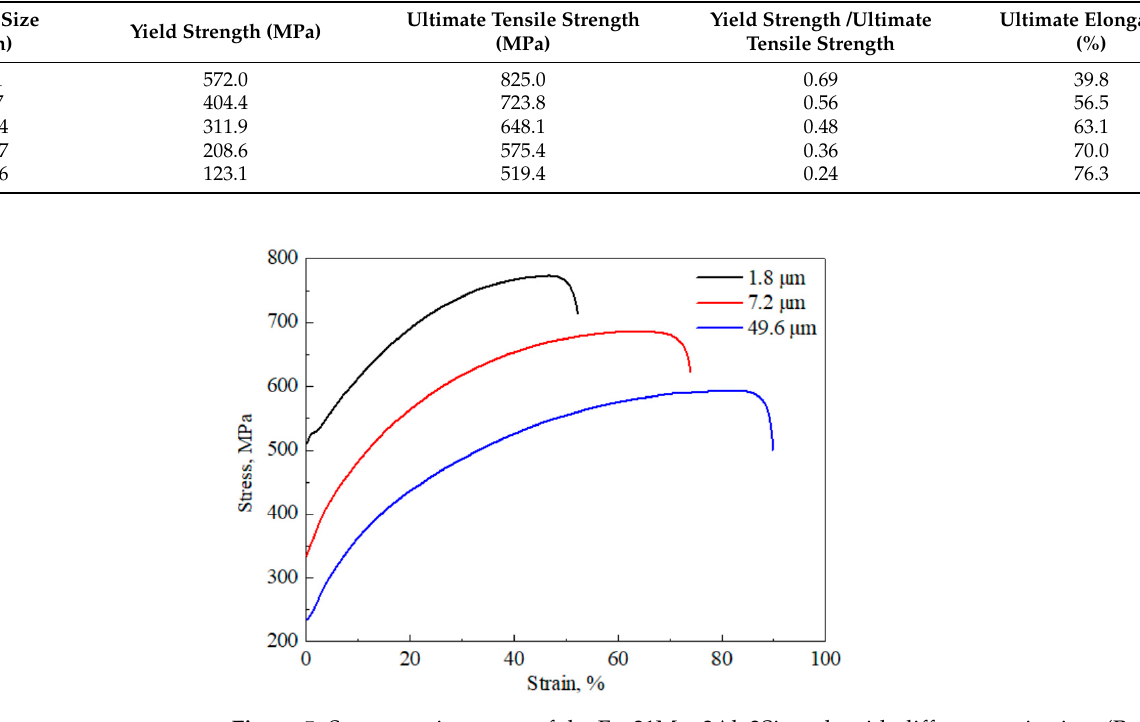
Figure 5. Stress–strain curves of the Fe–31Mn–3Al–3Si steels with different grain sizes (Reprinted with permission from Ref. [22], Copyright 2022 Elsevier).